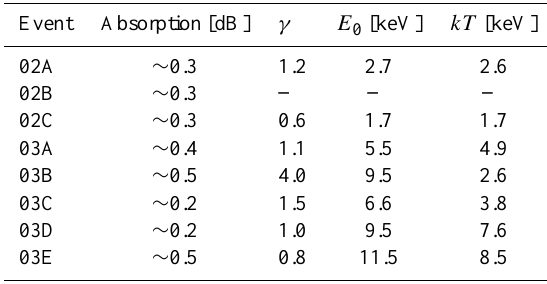
Table 4. Summary of the absorption data from the IRIS imaging riometer. The fitting parameter ( γ ), the estimated characteristic en- ergy ( E 0 ) and temperature ( kT ), from Eq. (1) is shown for each event.